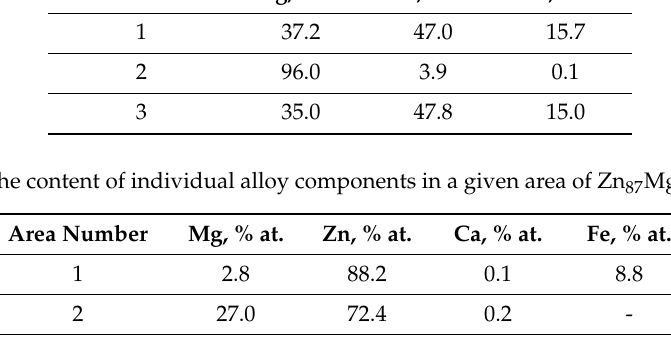
Table 2. The content of individual alloy components in a given area of Mg 72 Zn 24 Ca 4 alloy. Area Number Mg, % at.